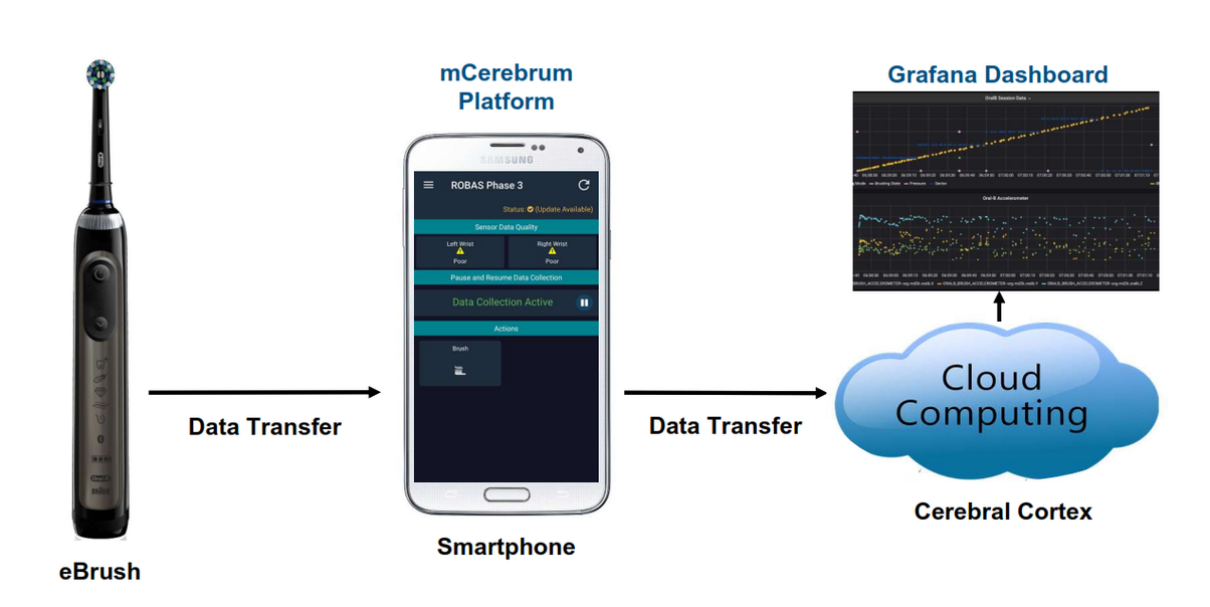
(Table 1). The balanced stratified sampling design allowed estimation of main effects as well as two-way interaction effects for the stratum-defining characteristics with a relatively modest sample size.